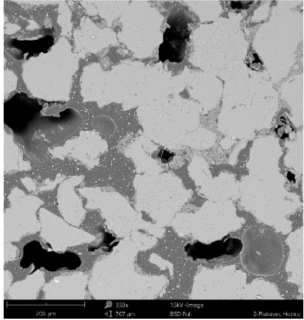
Figure 9. Phenom XL Desktop scanning electron microscope (SEM) photos.